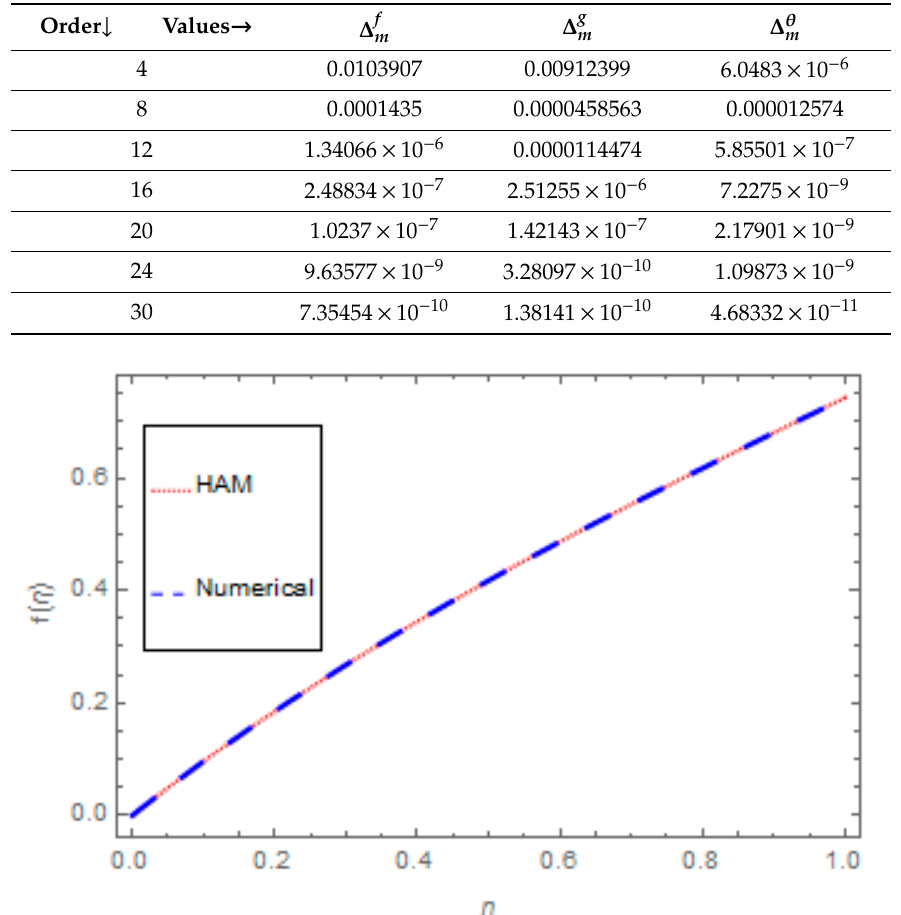
Figure 2. Comparison of the HAM and ND-Solve technique for velocity function f ( η )